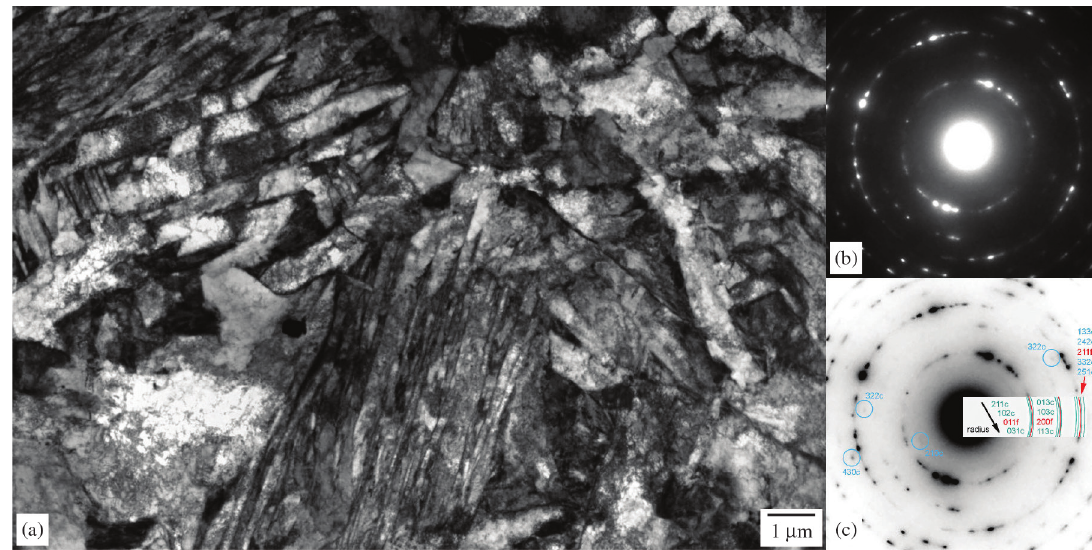
Figure 1. Thin foil TEM BF micrograph obtained after austenitizing at 900 °C/30 min and water quenching. Blocks and laths of martensite/ bainite are showing in (a) with its respective polycrystalline electron diffraction pattern in (b). Letters f and c identify respectively ferrite and cementite reflections in the key diagram in (c).